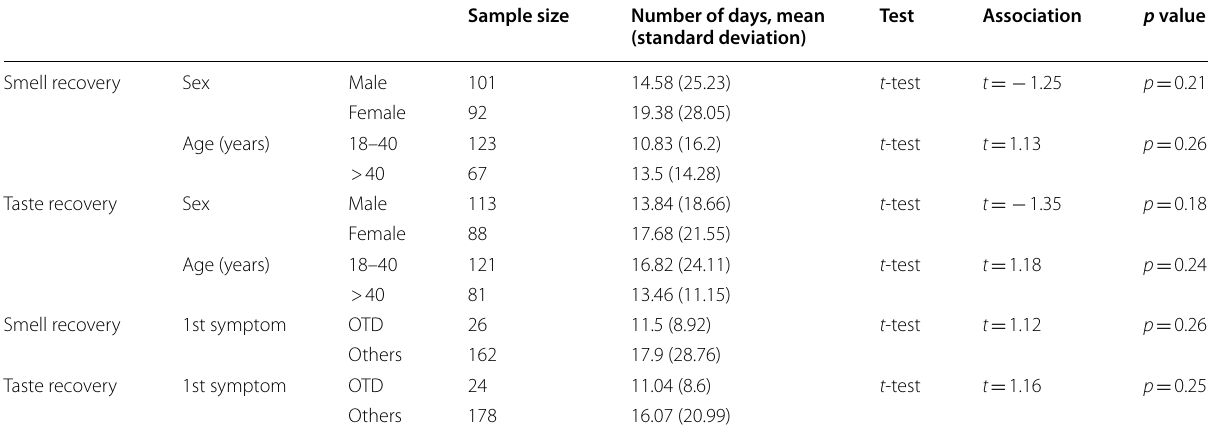
Table 6 Comparison of the effect of age, sex, and symptom at presentation on the duration of recovery Sample